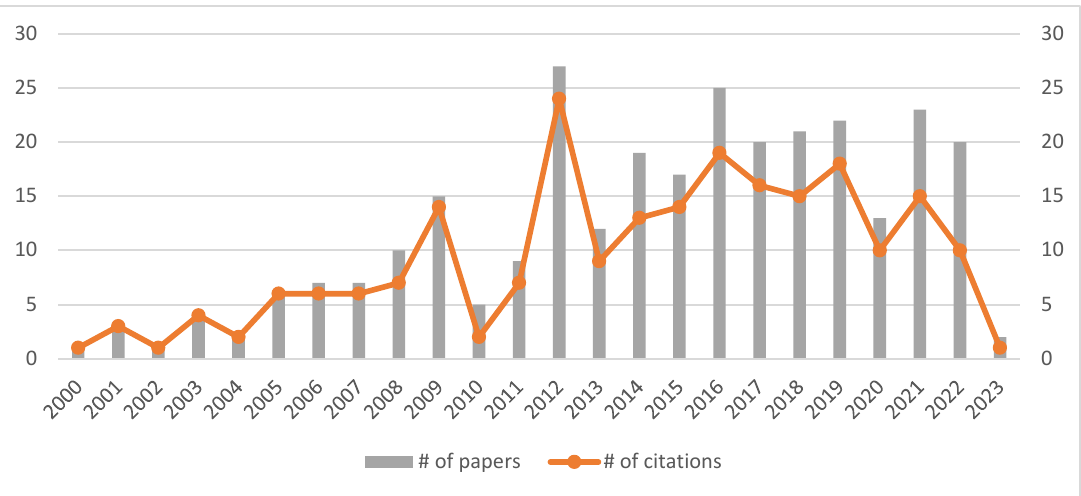
Figure 7. Number of papers and citations from 2000 to 2023; Source: Authors’ work based on Scopus.